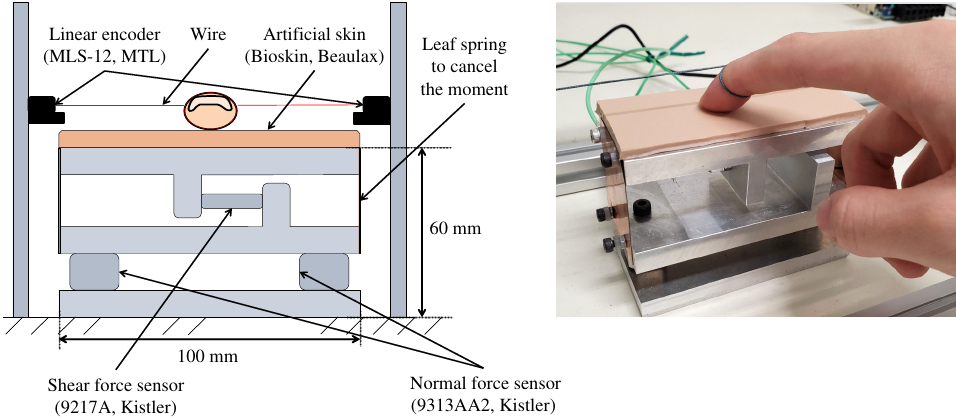
Figure 2. Measurement setup. The normal force was measured using two uniaxial force sensors installed in the lower part of the device, and the shear force was measured using a uniaxial force sensor fixed in the upper part of the device. The finger movement was measured through two wire encoders by winding a wire attached to the encoders around a finger.